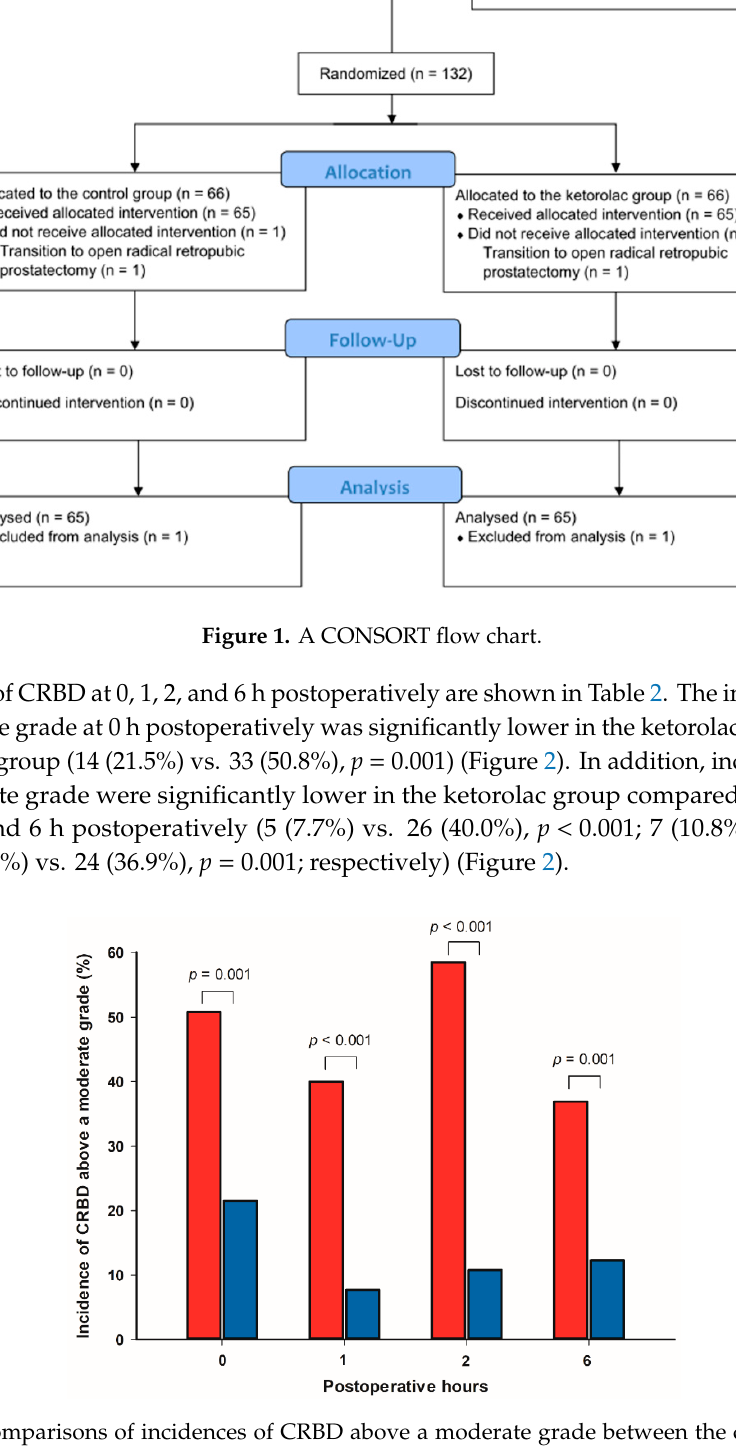
Table 2. Postoperative CRBD in patients undergoing robot-assisted laparoscopic radical prostatectomy.